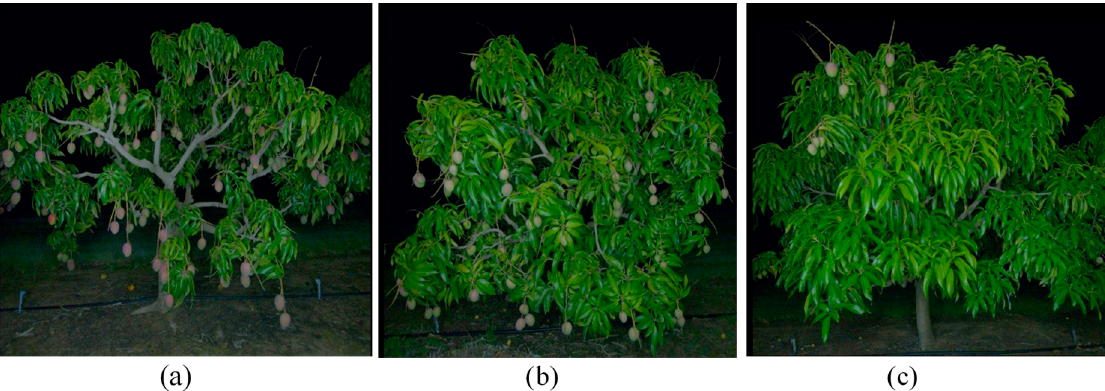
Figure 4. Example images from the three categories based on Silhouette score. Typical image in cluster-a ( a ), cluster-b ( b ) and cluster-c ( c ).